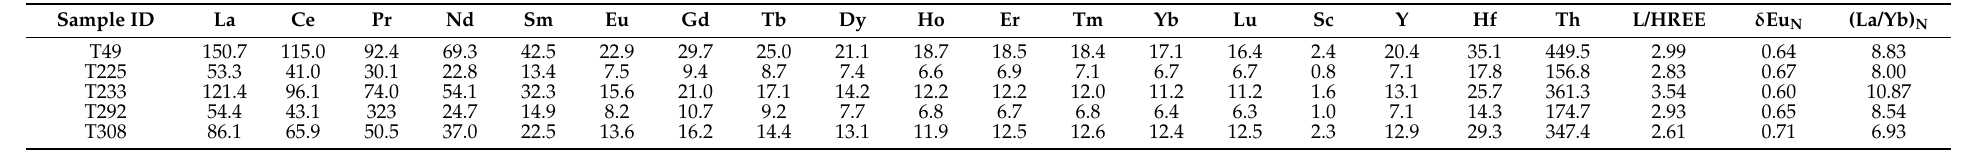
Table A3. REE and Sc, Y, Hf. and Th abundance in dust filters. Concentrations (ppm) are normalized to the C1 chondrite [93]. Normalized values (indicated by